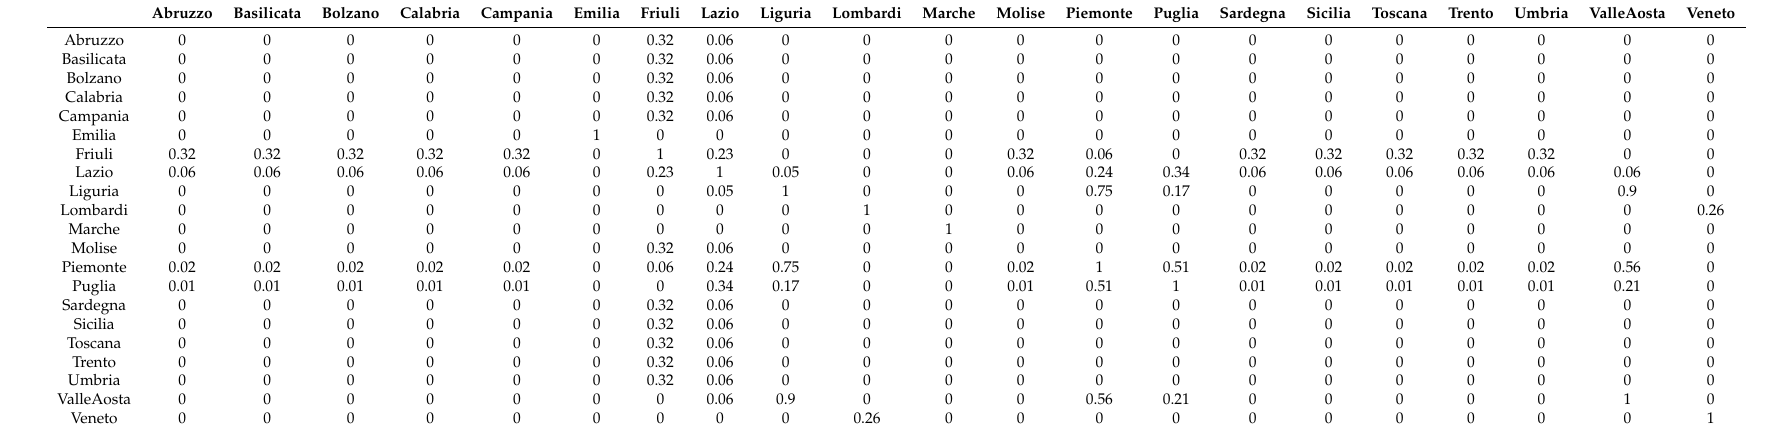
Table A45. Similarity values of Deceased network in the second week.